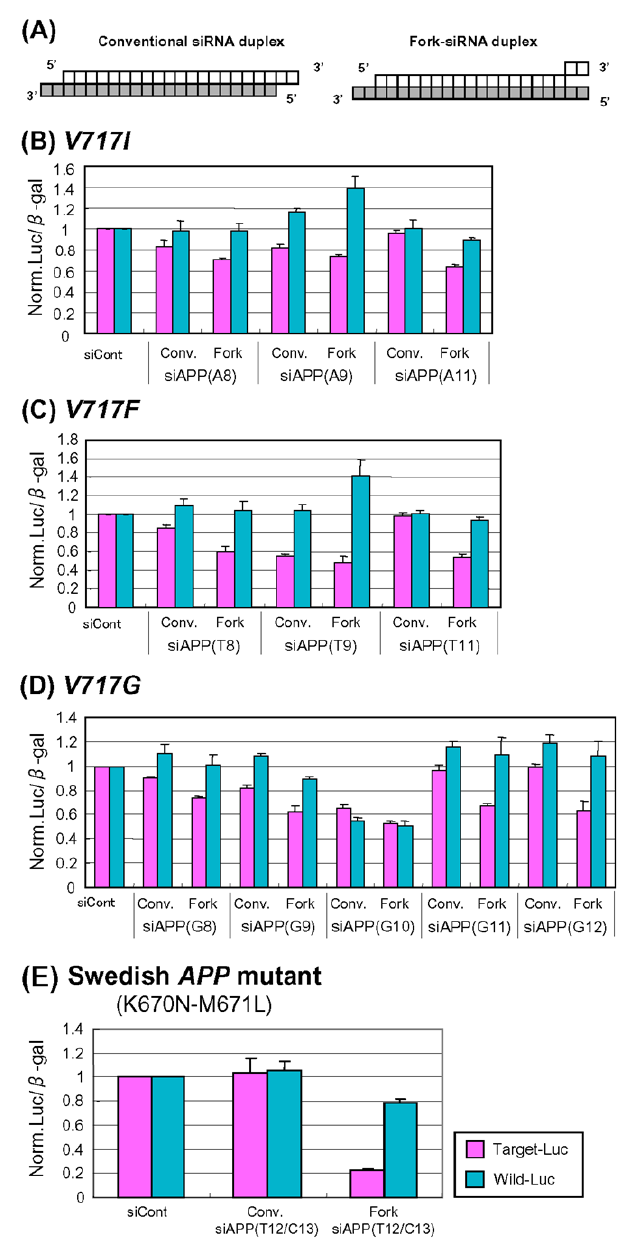
Figure 4. Effects of forked siRNA duplexes on APS-RNAi against APP mutants . (A) Schematic drawing of conventional and forked siRNA duplexes. Each box represents a ribonucleotide, and antisense-stranded siRNA elements are indicated by gray boxes. (B)-(E) Comparison of ASP-RNAi activities between conventional (Conv.) and forked (Fork) siRNA duplexes. Assessment of conventional and forked siRNA duplexes against the London V717I (B), V717F (C), and V717G (D) APP mutants and the Swedish (E) APP mutant was carried out as described previously [17]. The ratios of mutant and wild-type luciferase activities in the presence of siRNA duplexes were normalized against the control ratio obtained in the presence of siControl duplex. Data are averages of at least three independent determinations. Error bars represent standard deviations.